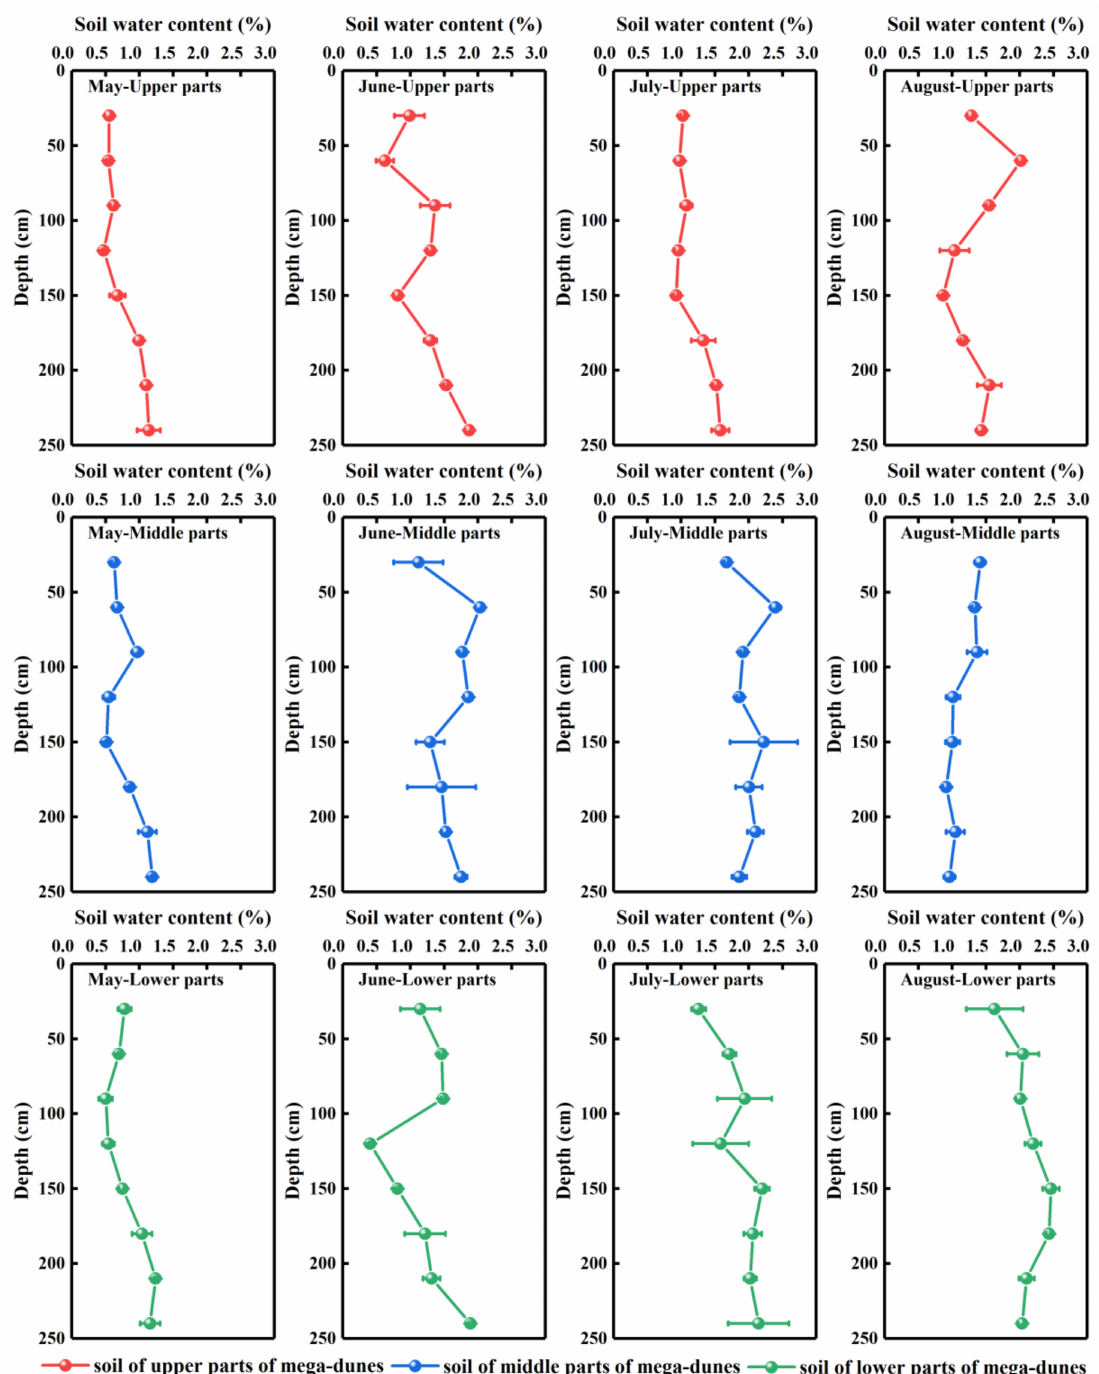
Figure 3. Vertical distribution of gravimetric soil water content of mega-dunes in the Badain Jaran Desert. Data are expressed as means ± 1SD. Rows one to three present the soil water content of the upper, middle, and lower parts of mega-dunes, respectively. Columns one to four present the soil water content in May, June, July, and August,